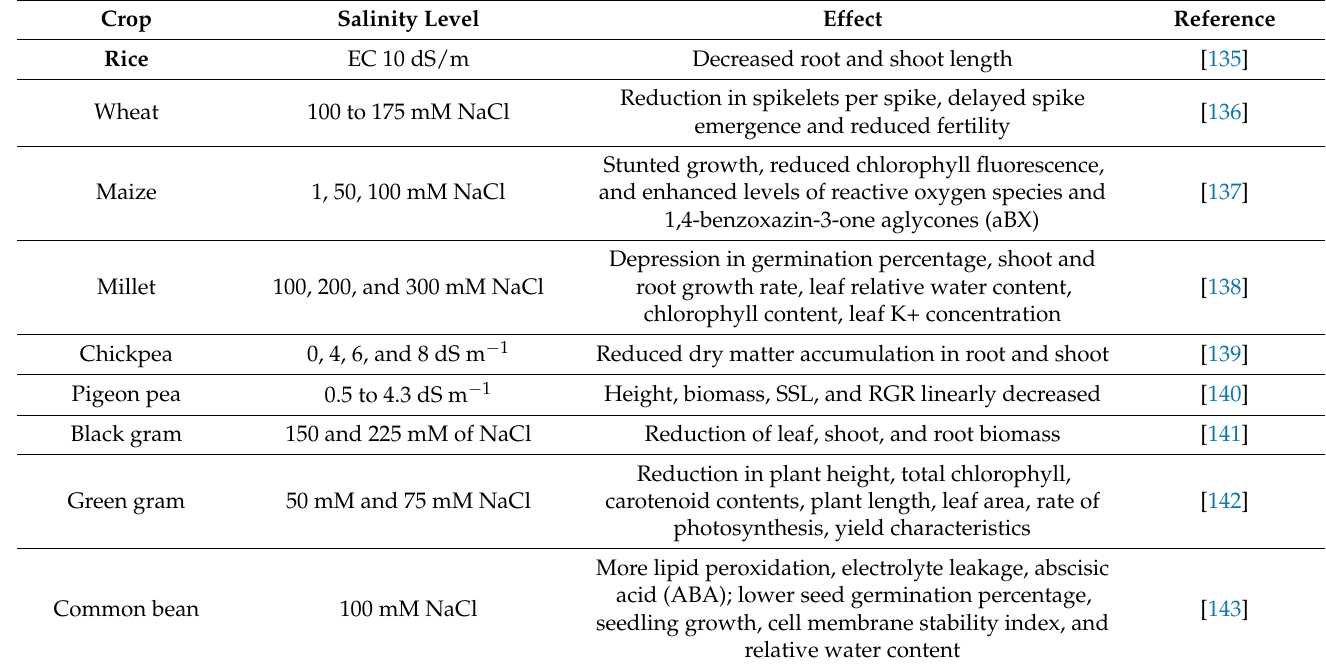
Table 4. Physiological and biochemical responses of plants under salinity